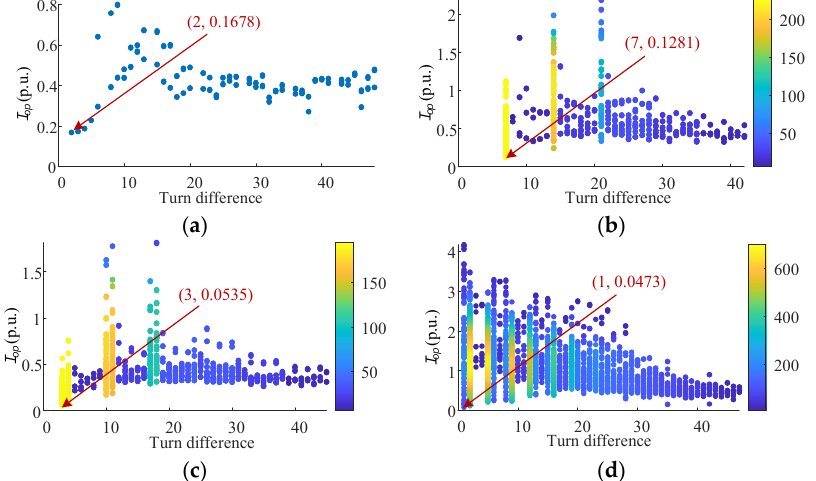
Figure 9. When s = 0.1, the simulation results of all possible internal short-circuit faults in rotor windings: ( a ) in-slot faults; ( b ) end faults in the same branch with different short turns; ( c ) end faults between two branches in the same phase; ( d ) end faults between phases.